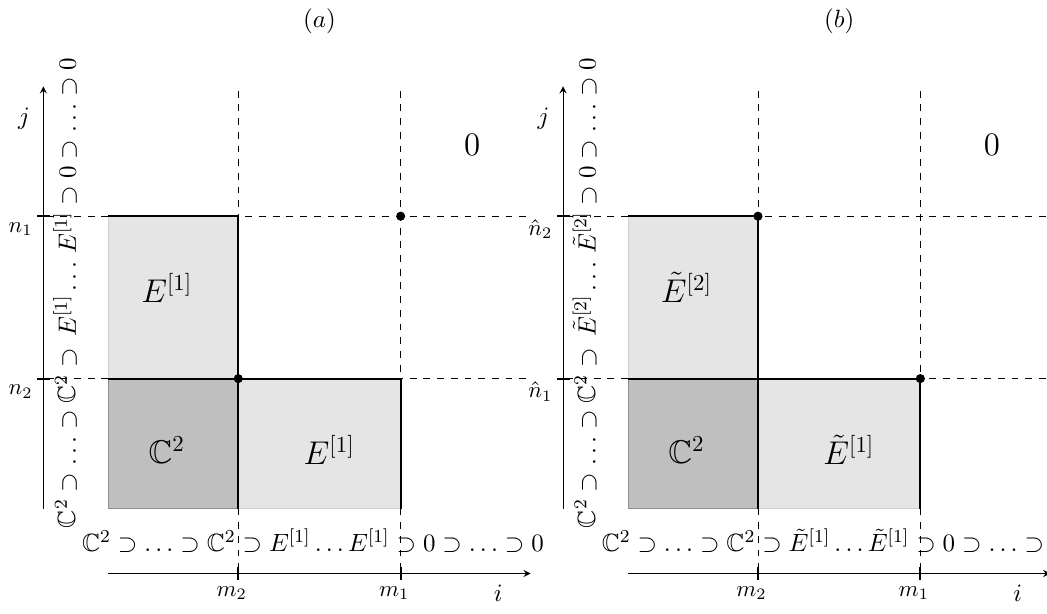
, ˆ n ˆ n and empty Young 1 > m 2 1 < 2